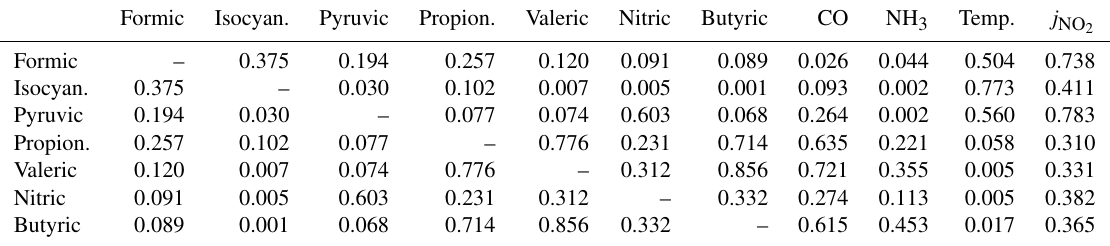
Table 2. Correlation coefficients ( r 2 ) for each gas-phase acid in the leftmost column compared to other gas-phase acids, chemical tracers, and other meteorological parameters in the table header (Propion. is propionic acid, Isocyan. is isocyanic acid, Temp. is air temperature). Formic Isocyan.